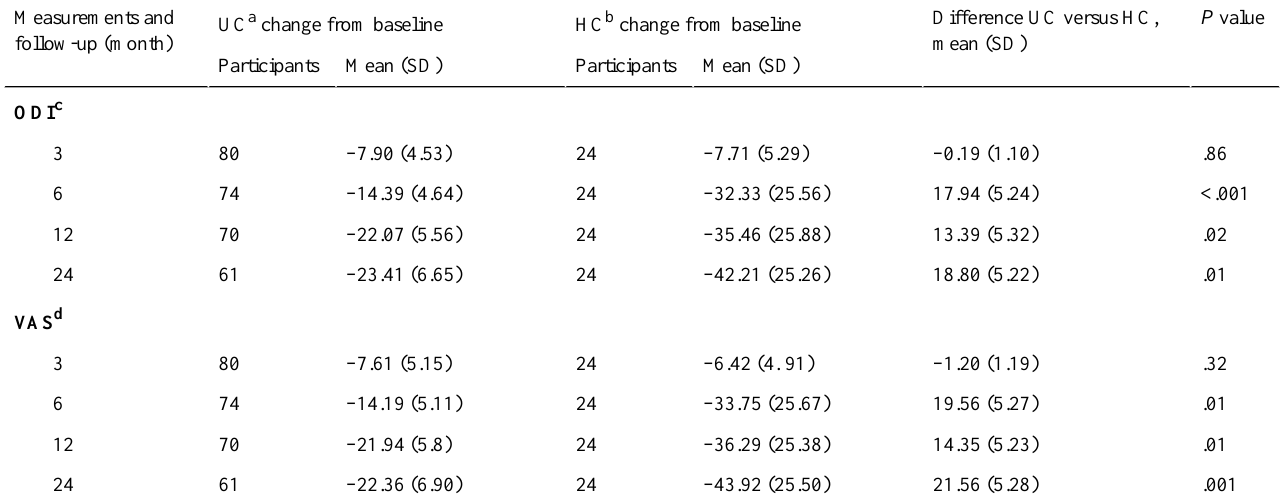
Table 5. Subgroup analysis of primary outcomes change from baseline and between-group difference outcomes.